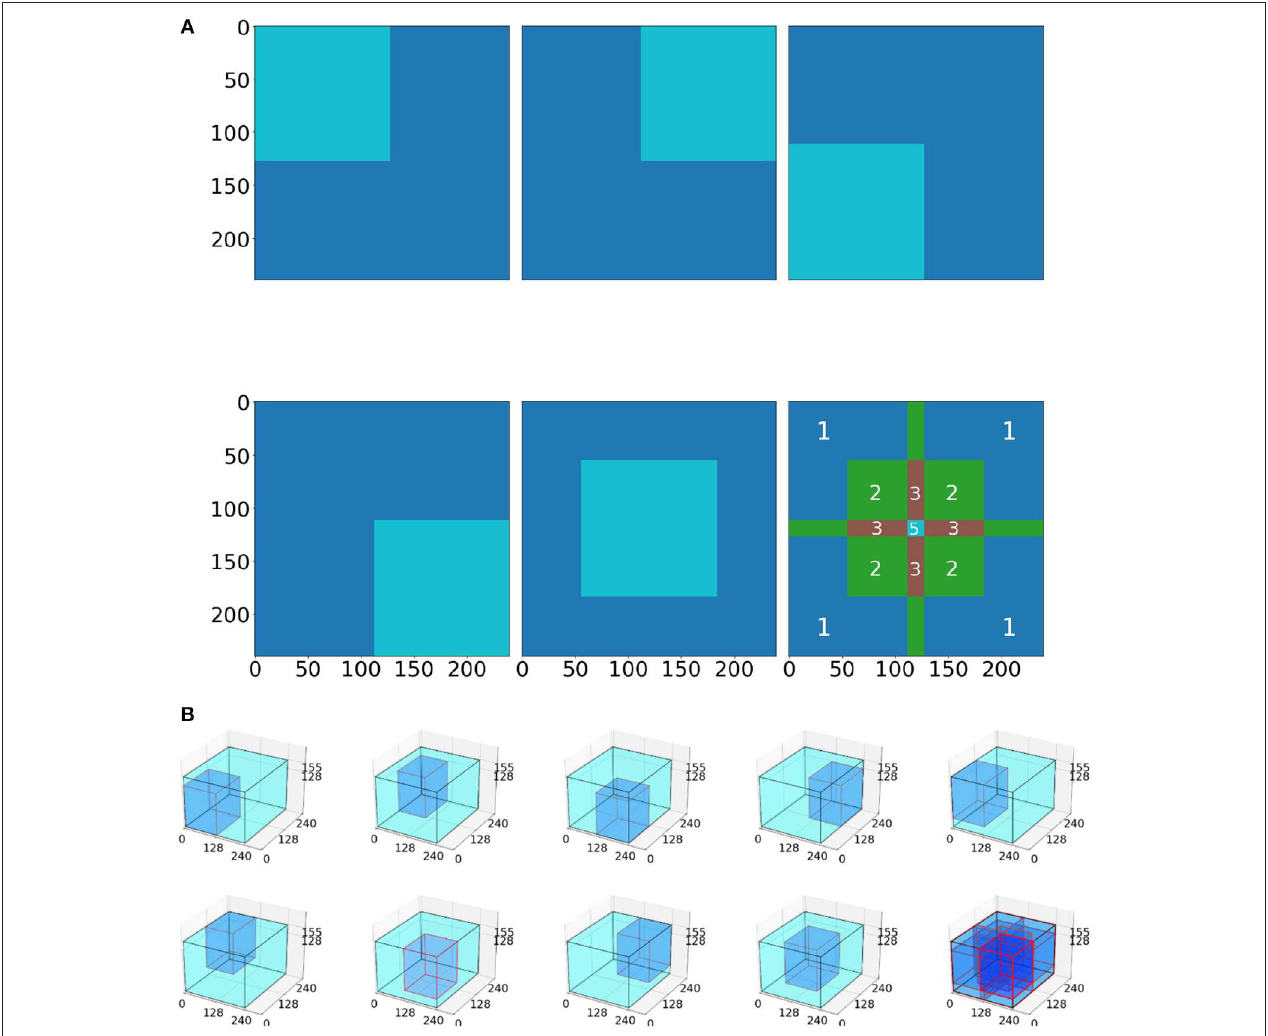
FIGURE 4 | Tiling process schematic. (A) In the 2D model, five tiles (4 corners, 1 center) are averaged to produce the whole image prediction. The 3rd picture in the 2nd row depicts the intensity of the tile overlapping. Notably, the tile predictions are either (i) first rounded and then averaged together, or (ii) first averaged together and then rounded. (B) Example for the 3D BraTS model, where the tiling algorithm is similar with the 2D, but this time uses nine tiles (8 corners and 1